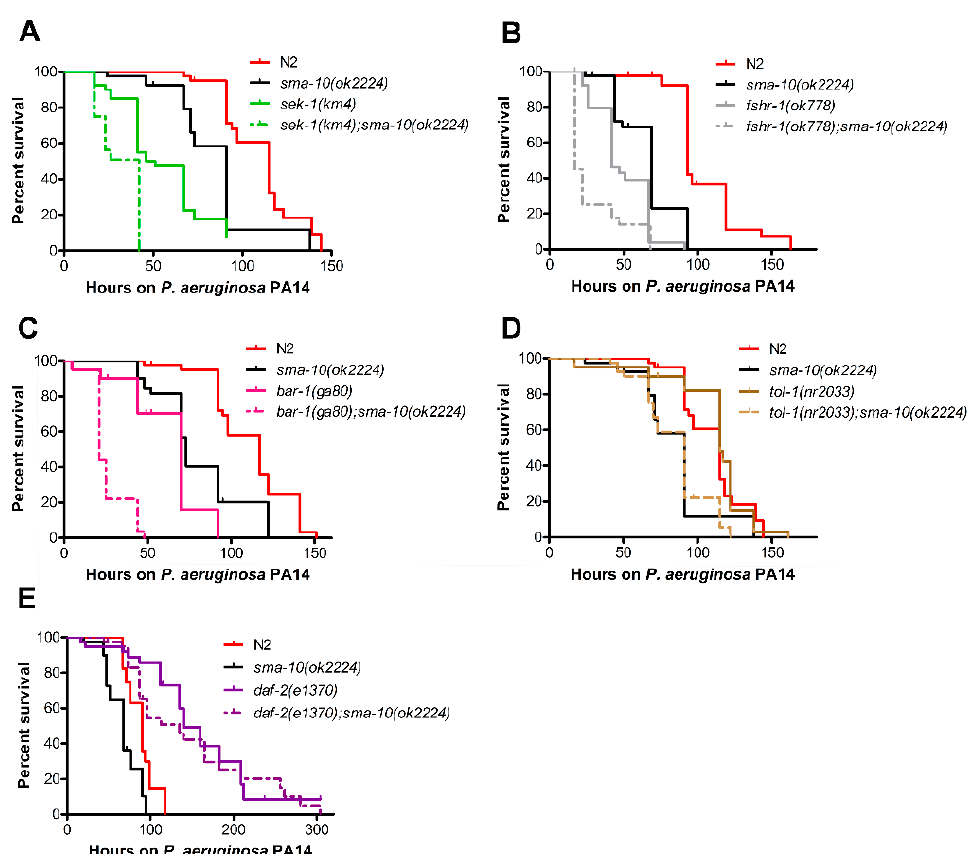
Figure 5. The immunological role of SMA-10 is independent of other proteins and pathways with antimicrobial properties, with the exception of DAF-2. Sensitivity of sma-10(ok2224) mutants to Pseudomonas aeruginosa (strain PA14) infection was compared to the correspondent double mutants with the following loss-of-function alleles: ( A ) sek-1(km4) , ( B ) fshr-1(ok778) , ( C ) bar-1(ga80), ( D ) tol-1(nr2033) , and ( E ) daf-2(e1370) . Kaplan–Meier plot was used to show the fraction of animals that survived overtime to PA14; data shown are from one representative experiment. Double mutants are even more sensitive than either single mutant, with the exception of daf-2(e1370);sma-10(ok2224) (panel E). Nematodes daf-2(e1370);sma-10(ok2224) are as resistant to PA14 infection as daf-2(e1370) , suggesting that SMA-10 acts upstream of DAF-2 within the same signalling pathway.